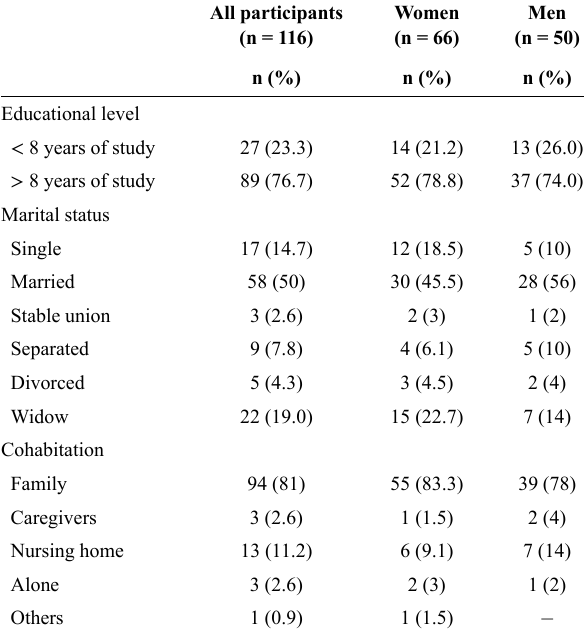
Table 1 - Sociodemographic characteristics of enrolled older cancer patients.